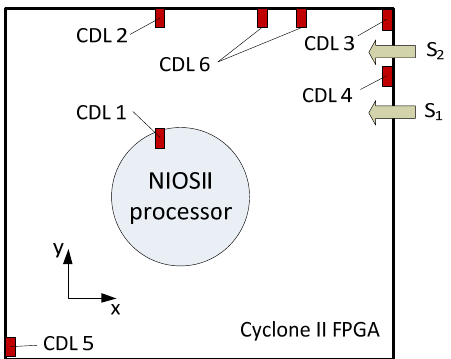
Figure 7. Test positions for the CDL on the Cyclone II field-programmable gate array (FPGA). The NIOS II processor and the signal inputs are shown for illustration.